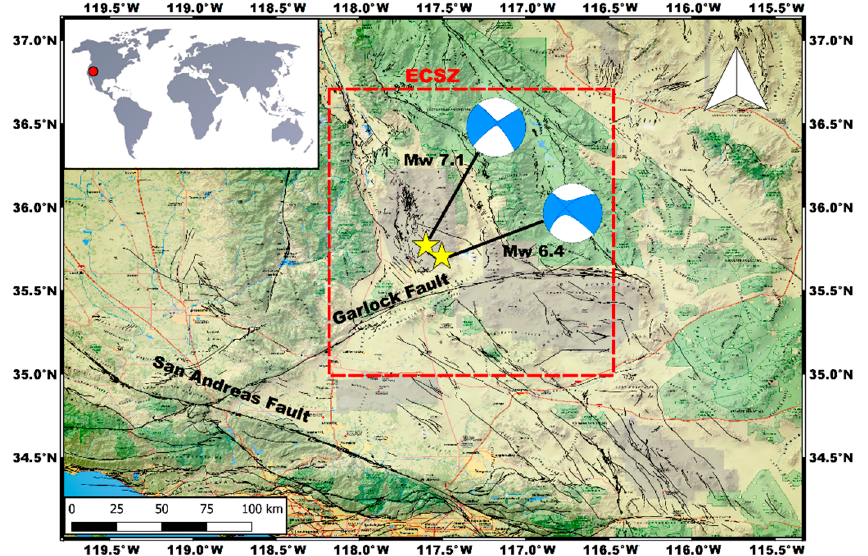
Figure 1. Overview of the area affected by the 2019 Ridgecrest sequence. The yellow stars represent the epicenters of the M w 6.4 and 7.1 earthquakes; the focal mechanisms were retrieved from USGS (https://earthquake.usgs.gov accessed on 12 February 2021). The black lines indicate the known mapped faults. The dashed red rectangle indicates the eastern California shear zone